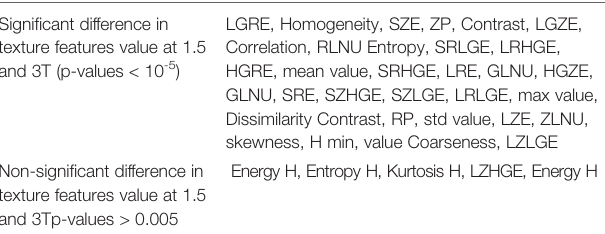
TABLE 2 | Texture features presenting signi fi cant or non-signi fi cant differences at 1.5 and 3T based on the heterogeneous phantoms examination (student ’ s paired